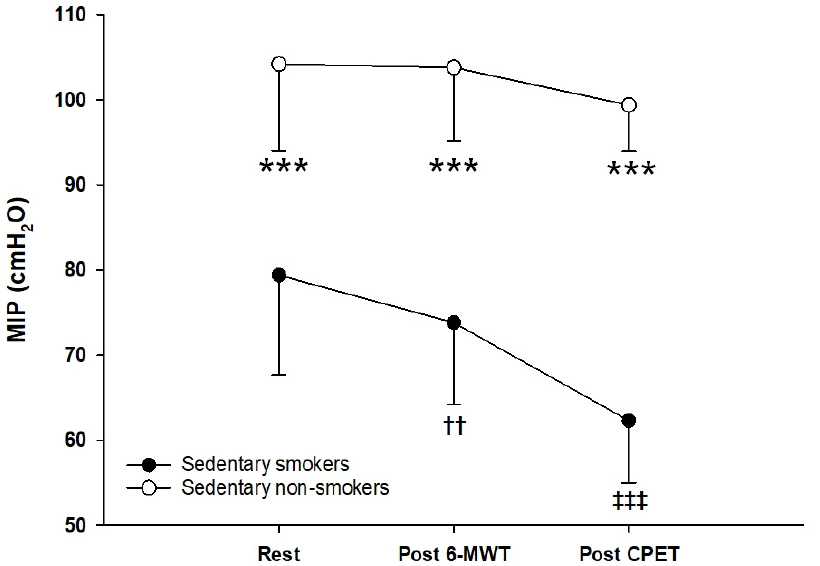
Figure 5. Mean maximal inspiratory pressure (MIP) at rest, after sub-maximal exercise (6-MWT) and maximal exercise (CPET) in sedentary smokers (black circles) ( n = 25) and sedentary non-smokers (white circles) ( n = 25). t -test for independent samples is used for analysis; *** p < 0.001; Rest, Post-6-MWT compared in sedentary smokers versus non-smokers. t -test for dependent samples is used for analysis of Post-6-MWT and post CPET compared to rest in sedentary smokers and non-smokers: †† p < 0.01; ‡‡‡ p < 0.001.